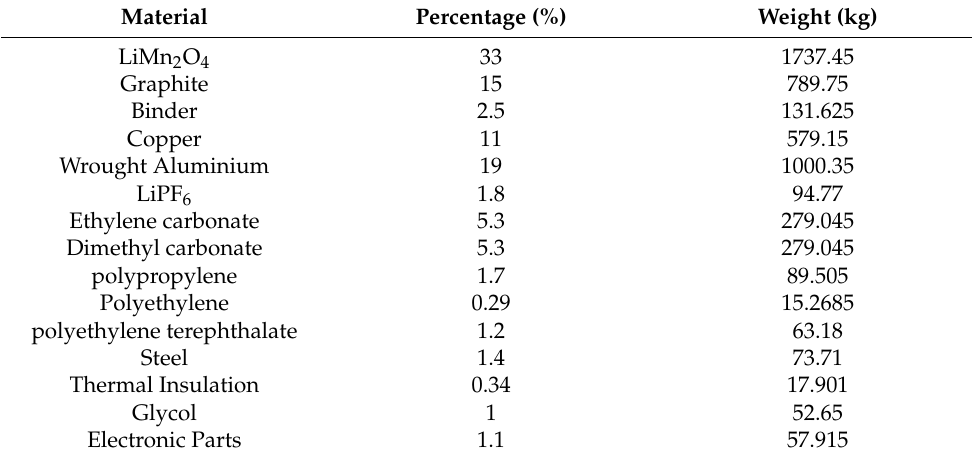
Table 5. Scaled BOM for Full Electric HGV